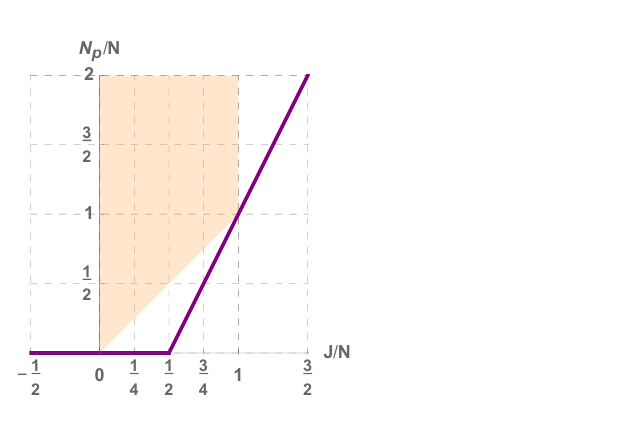
exist. The purple lines represent the unitarity j 0 i